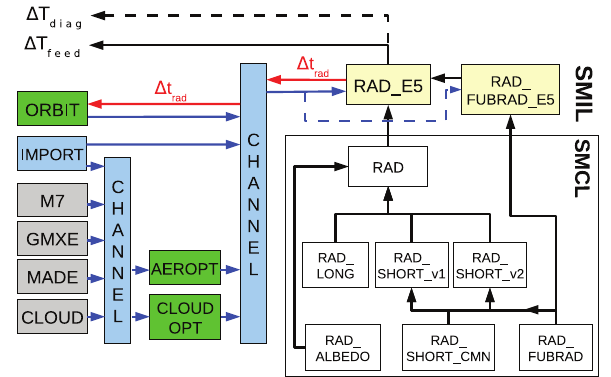
Figure 1. Diagram of the revised radiation structure in EMAC. The relationship between the various Fortran95 modules of RAD is given on the right-hand side. The different MESSy layers SMCL and SMIL are indicated. The left-hand side shows the connection of RAD to other submodels. The grey boxes indicate existing submod- els delivering input for the radiation, whereas the green boxes show new submodels, which are now separated from the radiation code. The blue arrows indicate the input to RAD and RAD_FUBRAD (dashed) via the channel infrastructure and the red arrows indicate the trigger, passed from RAD to ORBIT. The black arrows indicate the dependencies of the Fortran95 modules through Fortran USE statements. The direction of the arrows indicates where the differ- ent modules are used. A detailed description is given in the